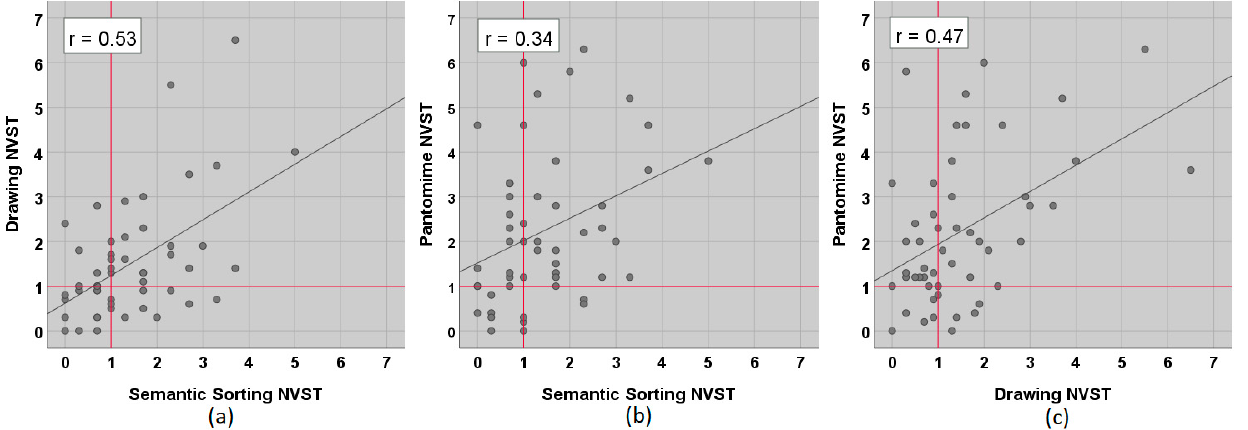
Figure 1. Relationship of the three subtests of the Nonverbal Semantics Test (NVST). ( a ) Drawing vs. Semantic Sorting, ( b ) Pantomime vs. Semantic Sorting, and ( c ) Pantomime vs. Drawing. Data points represent normative scores. High scores indicate a more impaired performance. Red lines mark the cut-off (1).